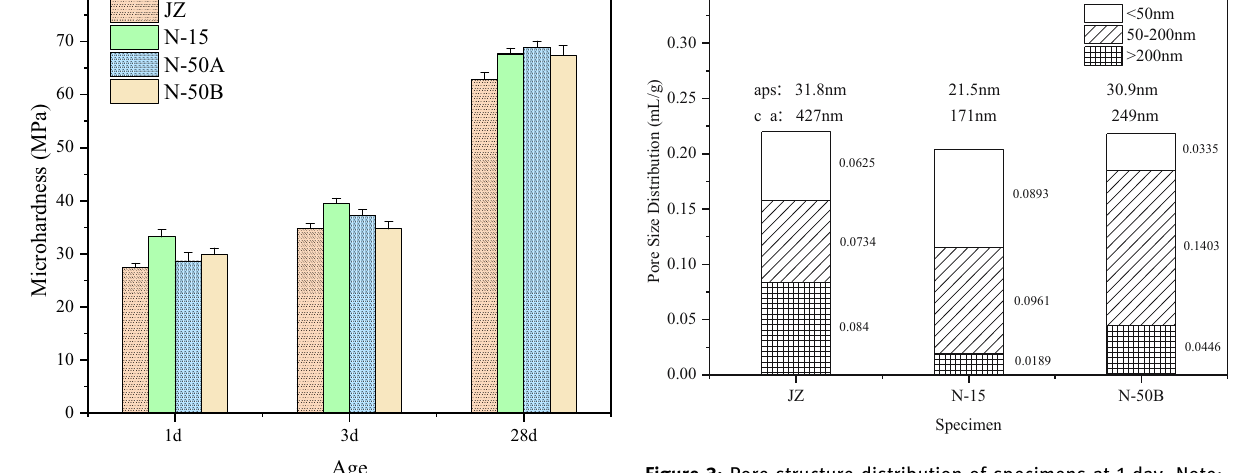
Figure 3: Pore structure distribution of specimens at 1 day. Note: aps = average pore size, ca = critical pore